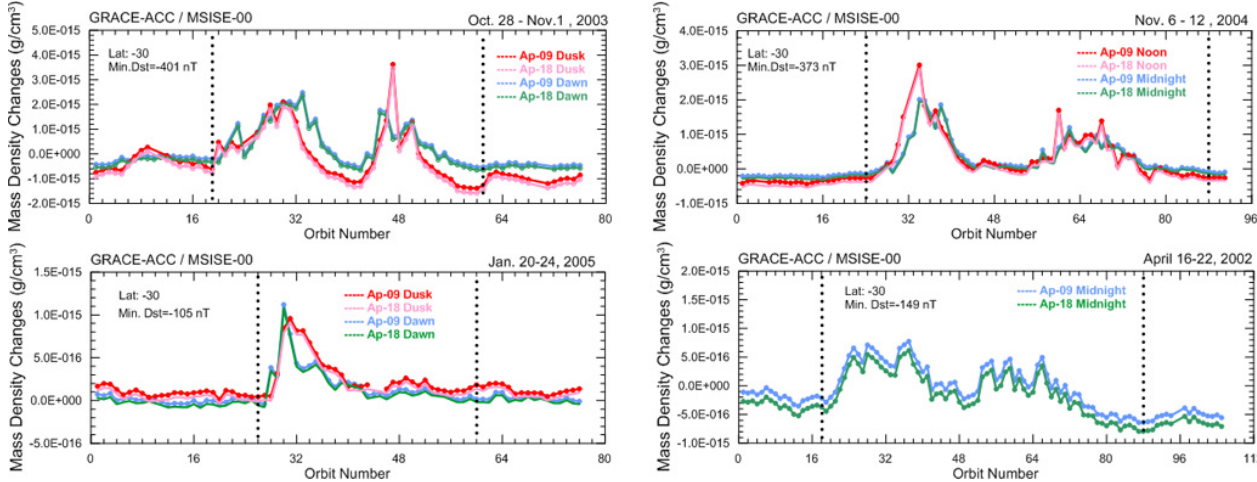
Fig. 4. Examples of specified time series of mass density changes. The vertical dotted lines indicate the beginning and ending time (orbit number) of the time series. In addition to the time series calculated using Ap = 18nT (pink color for dusk or noon sector, green for dawn or midnight), the time series calculated from Ap = 9nT (red color for dusk or noon sector, blue for dawn or midnight) are also given for a